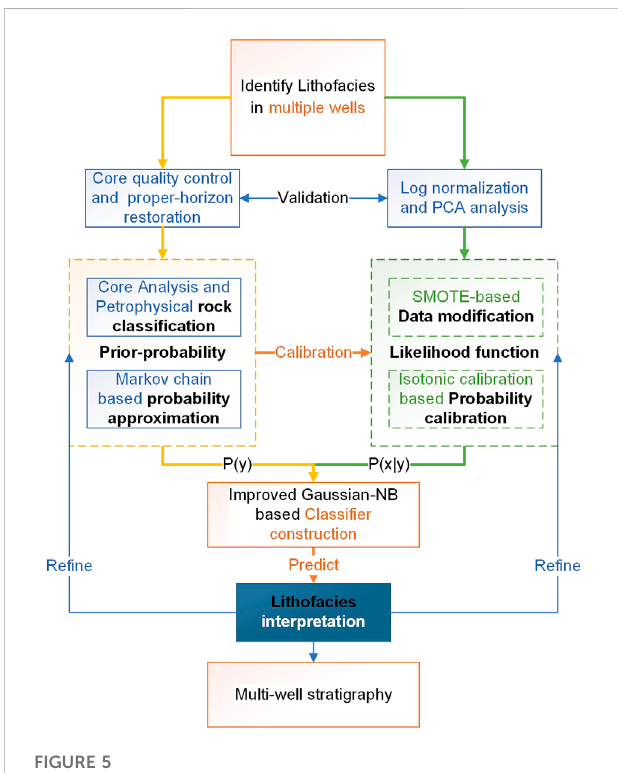
FIGURE 5 Lithofacies classi fi cation work fl ow based on well logs and core